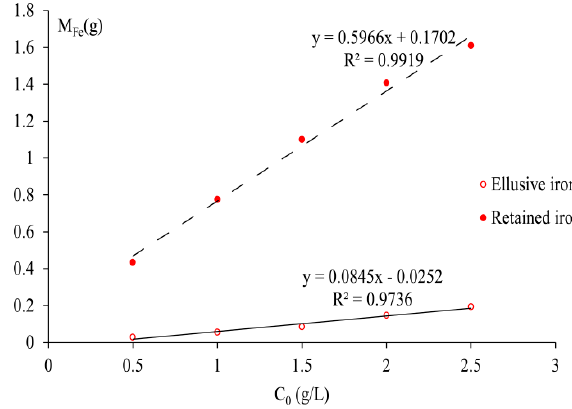
Figure 8. Relationship between residual iron and discharged iron versus initial injected concentration.